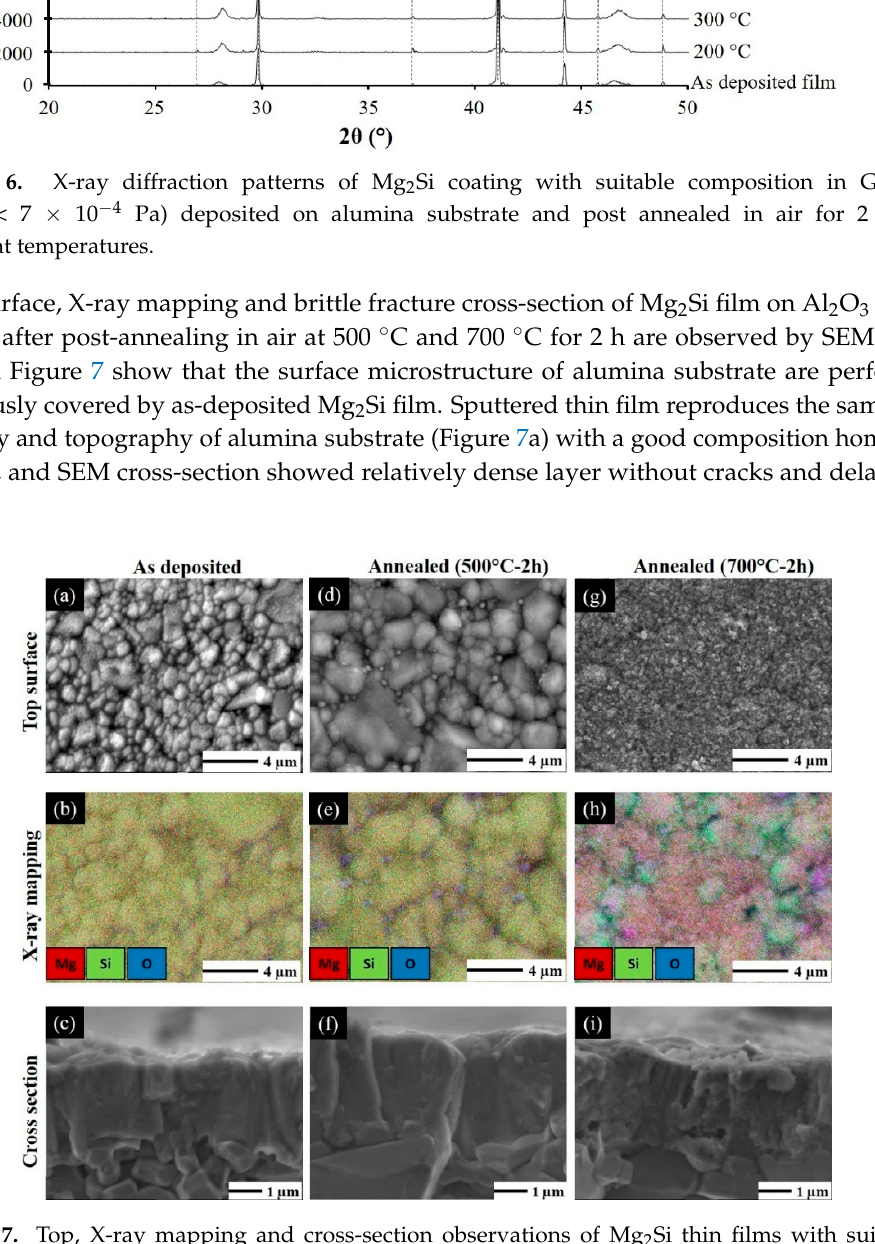
Figure 8. DC electrical resistivity of Mg 2 Si films vs. temperature for different Si atomic concentrations. (Group I: R P < 7 × 10 − 4 Pa and Group II: R P ≥ 7 × 10 − 4 Pa).